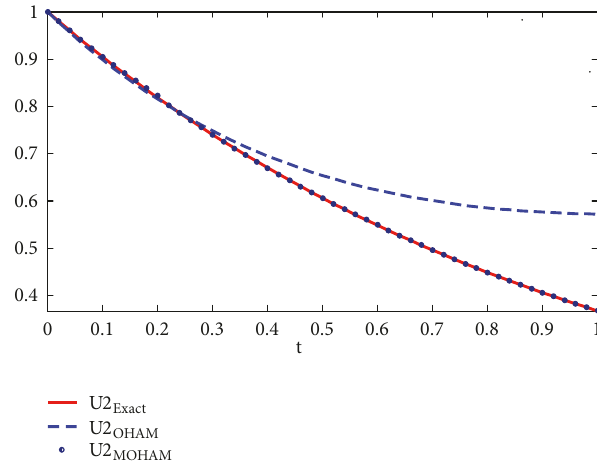
Figure 2: The results of OHAM, MOHAM, and exact solution for u2 in Example